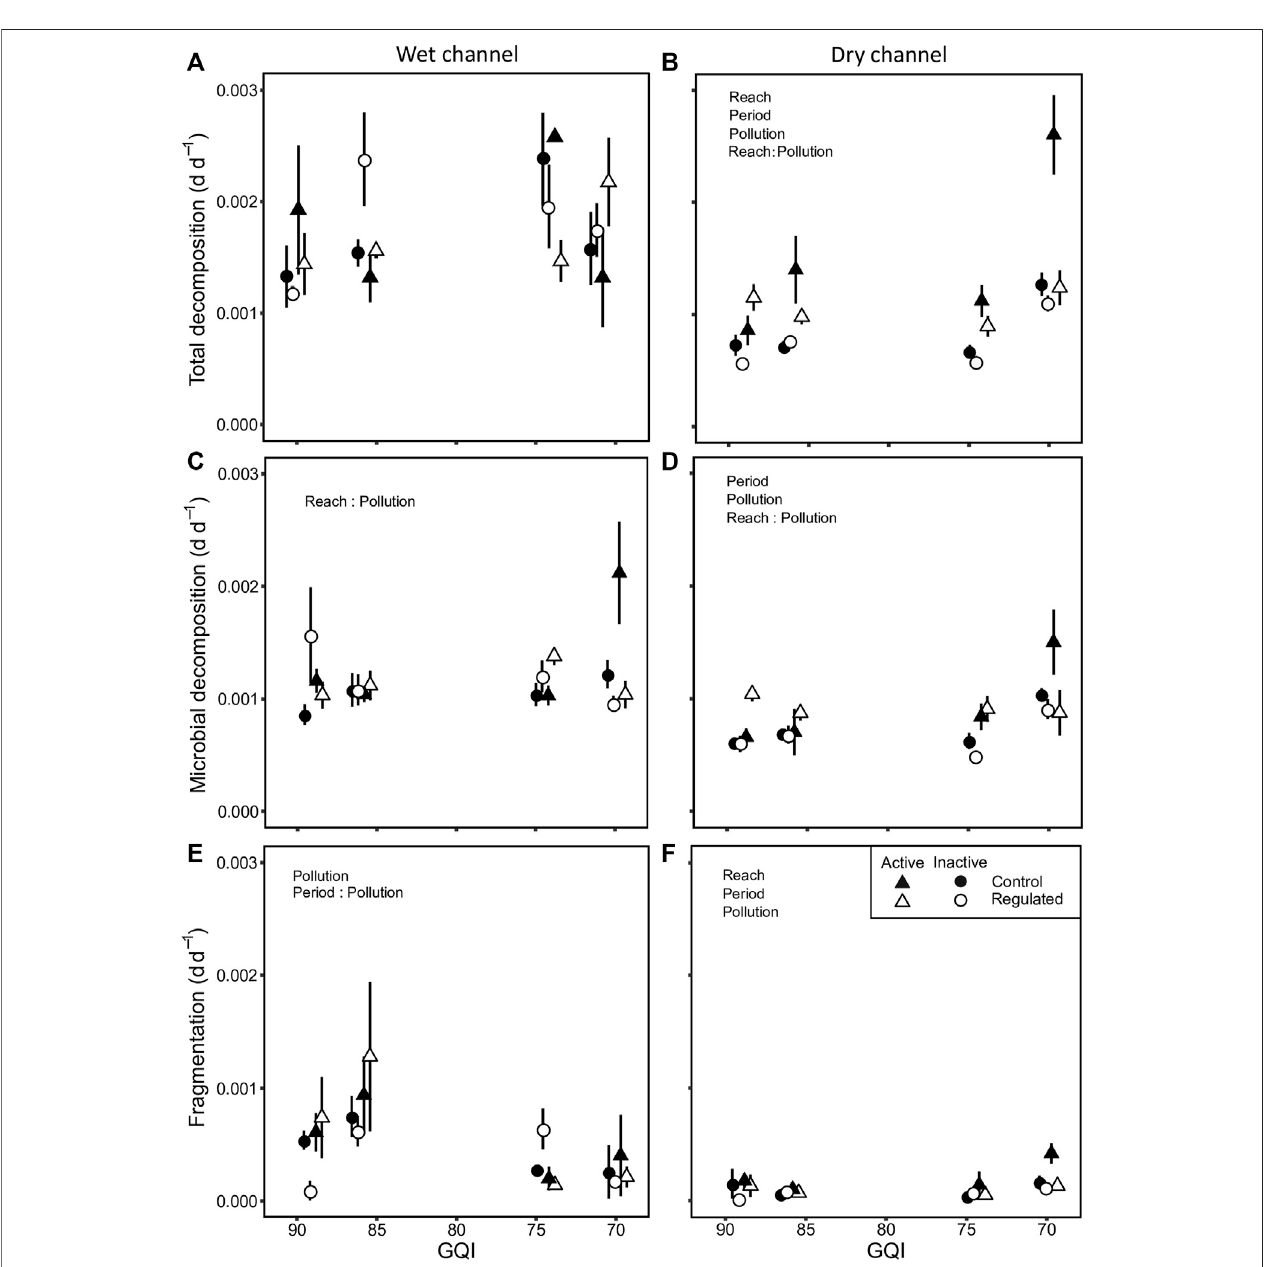
FIGURE 3 | Leaf litter decomposition in the wet (left side) and dry channel (right side): (A, B) total decomposition, (C, D) microbial decomposition, and (E, F) fragmentation. Values are mean and error bars show standard error. The text in the background indicates signi fi cant single-factor effects or interactions. GQI is the General Quality Index and the scale is inverted to make easier the interpretation of the fi gure, ranging from good (low pollution) to acceptable quality level (moderate pollution). GQI values have been jittered to avoid overlapping points.